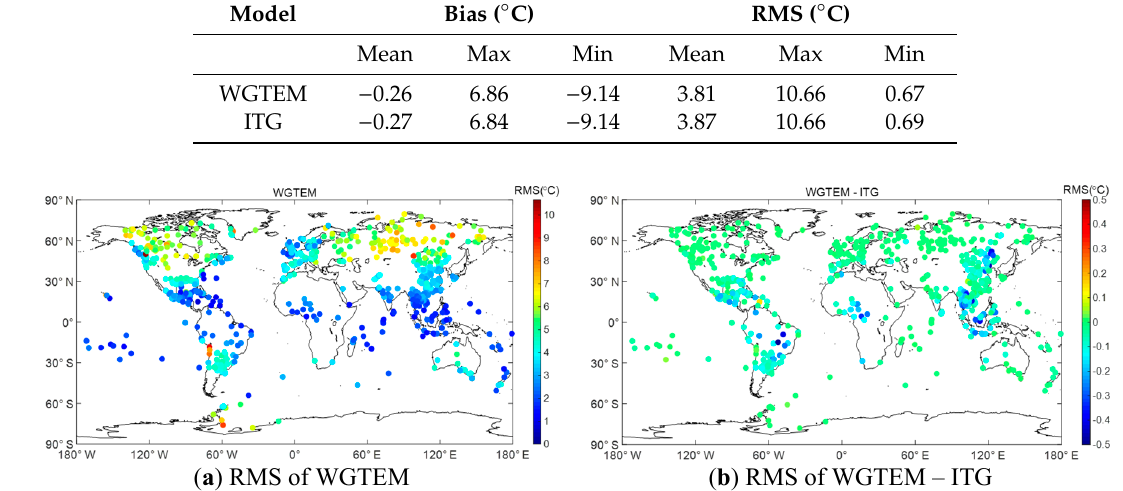
Figure 5. Temperature RMS from WGTEM at each station, and comparison of global temperature RMS differences between ITG model and WGTEM validated by NOAA data.